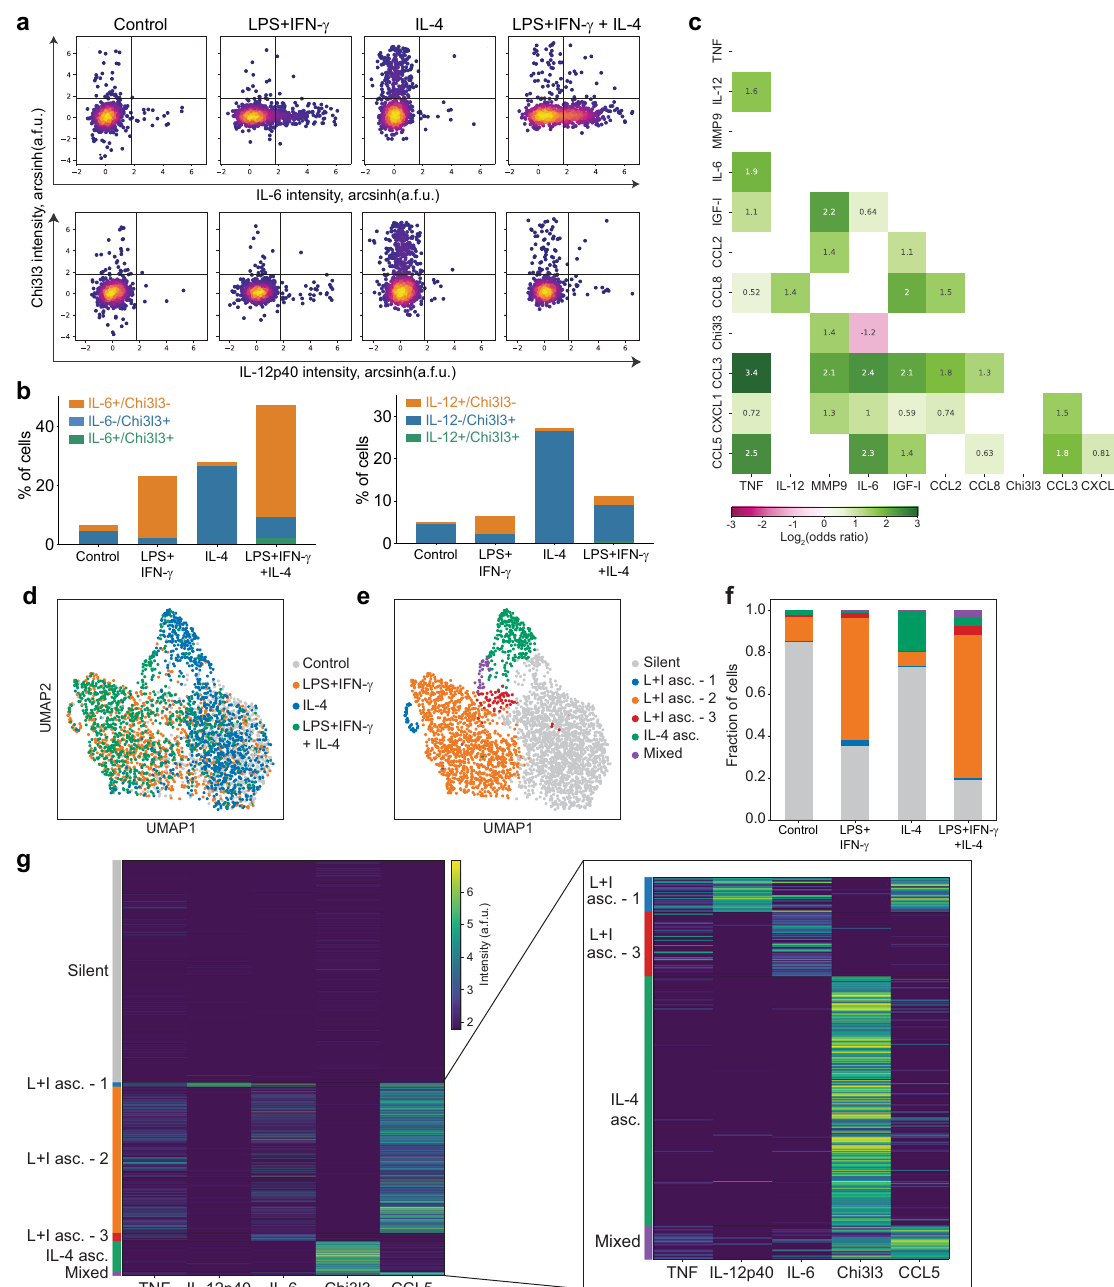
Fig. 5 Single-cell secretion assay identi fi es long-term specialization in co-stimulated cells. A multiplexed single-cell secretion assay was used to measure cytokine/chemokine production in individual BMDMs stimulated for 48 h with media alone, 10 ng/ml LPS + 10 ng/ml IFN- γ , 100 ng/ml IL-4, or both. a Density scatter plots of single-cell secretion intensity (a.f.u.) across individual cells for Chi3l3 vs IL-6 (top) and Chi3l3 vs IL-12p40 (bottom). b Quanti fi cation of single- and double-positive cells after co-stimulation for Chi3l3 and IL-12p40 (left) and Chi3l3 and IL-6 (right). c Pairwise odds ratios for all secreted proteins measured in co-stimulated cells. Data are presented as the log 2 (odds ratio). The color bar indicates the direction and magnitude of the association. Odds ratios with an associated p -value > 0.05 (determined by two-sided Fisher ’ s exact test) are set to 0. d-e UMAP visualization of single-cell secretion data for 5 proteins (Chi3l3, CCL5, IL-6, IL-12p40, and TNF α ), colored by stimulation ( d ) or consensus cluster ( e ). f Quanti fi cation of the fraction of cells present in each consensus cluster identi fi ed by ensemble clustering. g Heatmap of secretion pro fi les for the fi ve secreted proteins in d grouped by consensus cluster. Inset is a magni fi ed version of the smaller clusters. All single-cell secretion data presented is pooled from two biological replicates. L + I asc. LPS + IFN- γ -associated; IL-4 asc. IL-4-associated. Source data are provided as a Source Data fi